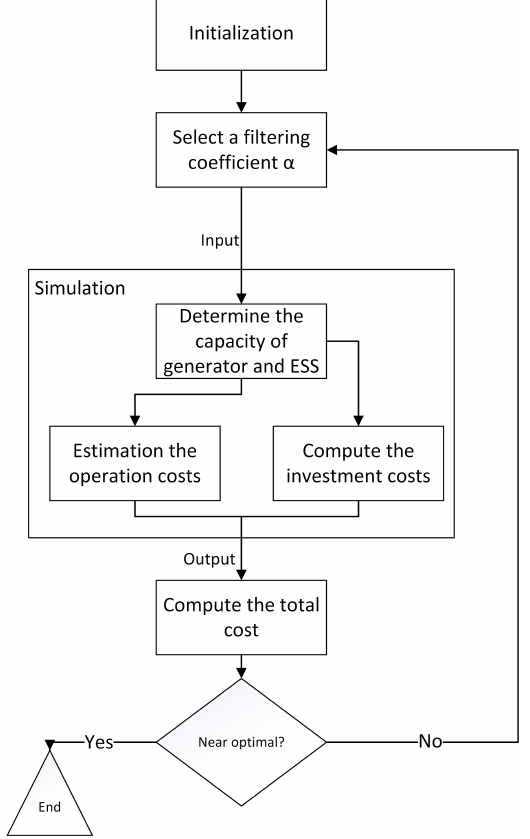
Figure 2. The research framework for the hybrid